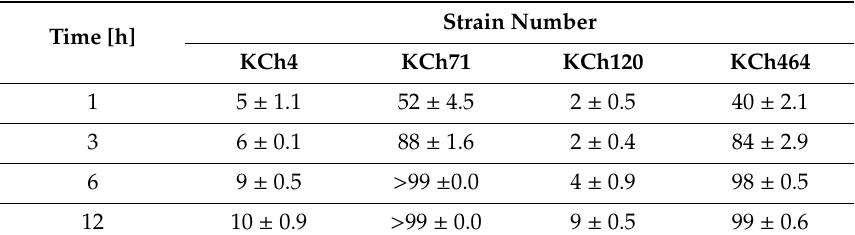
Table 2. Transformation of the substrate 1 by selected strains.